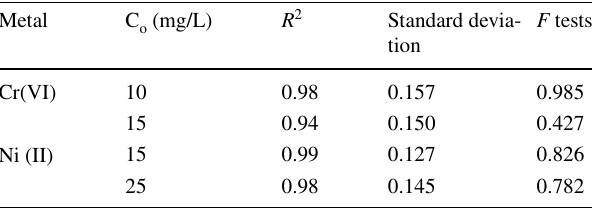
Table 3 Statistical analysis carried out to check the reliability of the results obtained in the